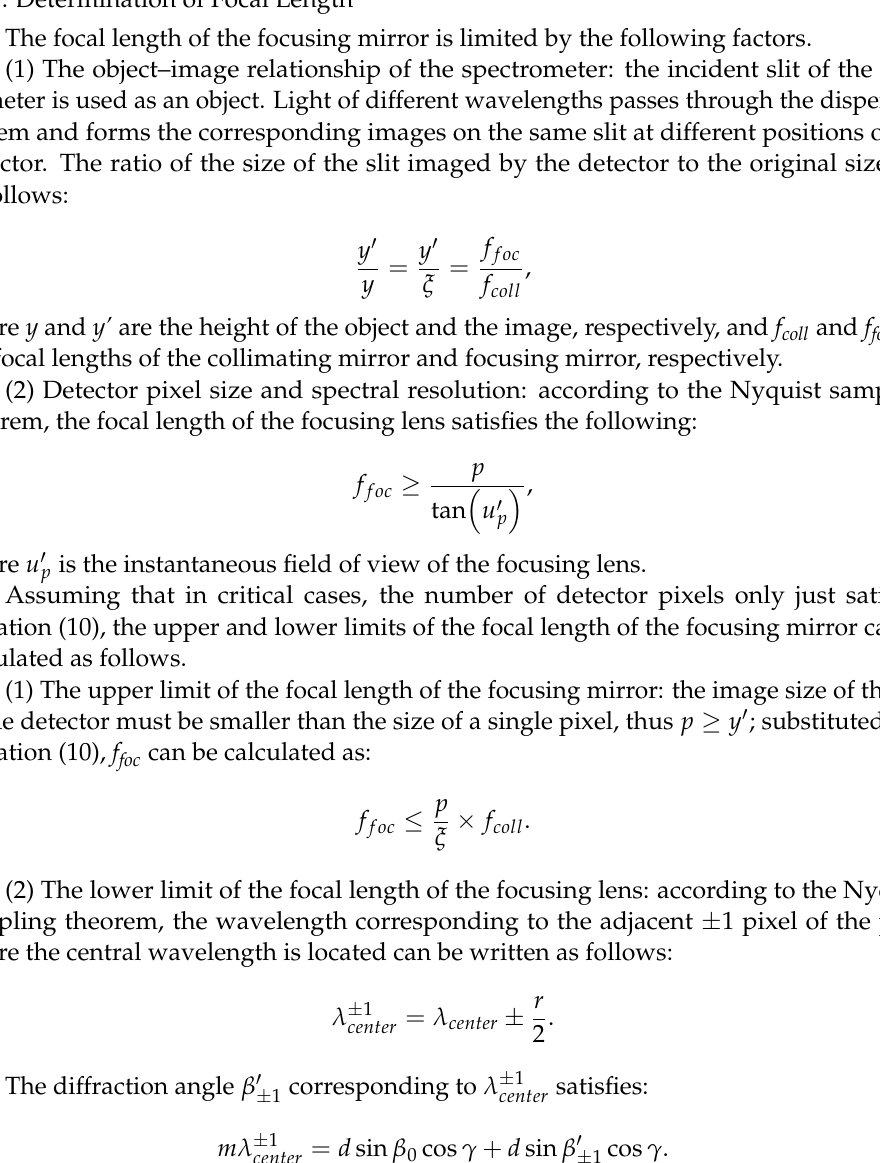
Figure 4. Schematic of the echelle spectrometer.